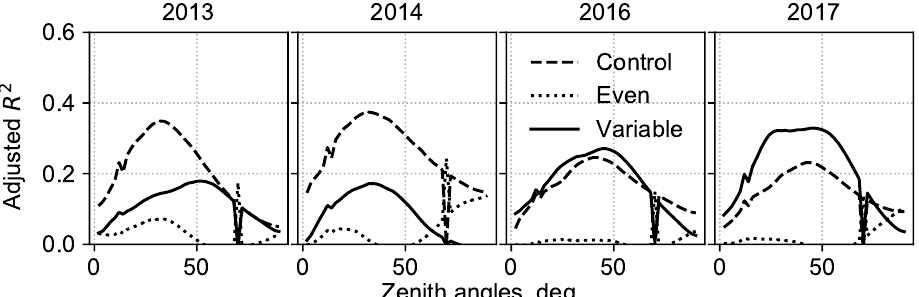
Figure 10. Adjusted R 2 versus zenith angles between snow depth and sky-view factor over four years at